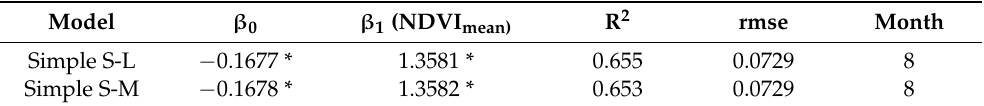
Table 8. R-squared, rmse, month and best fit model for simple regression (* p -values: <0.05). Model β 0 β 1 (NDVI mean) R 2 rmse Month Simple S-L − 0.1677 * Simple